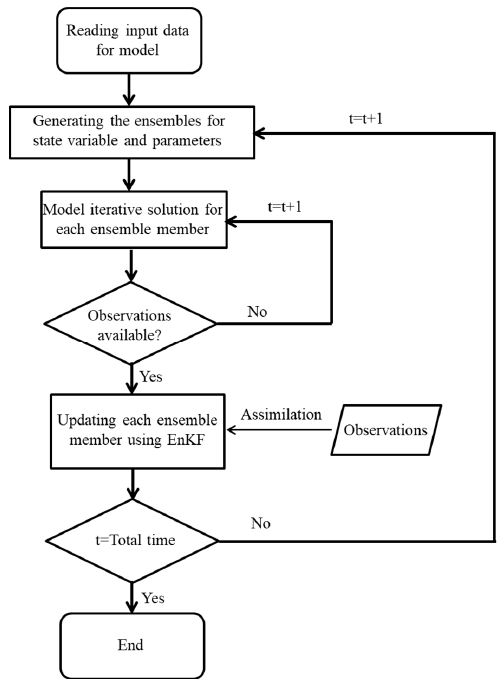
Figure 1. Flowchart of data assimilation for soil water movement and solute transport using the EnKF coupled with HYDRUS-1D.